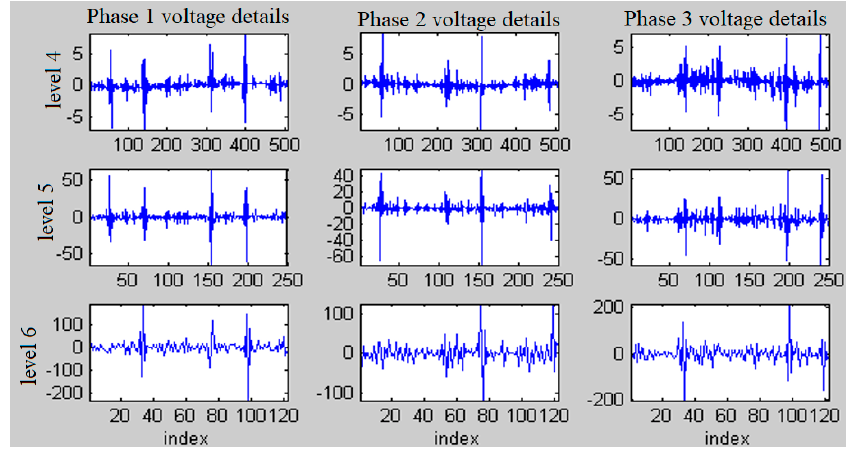
Energies 2022 , 15 , x FOR PEER REVIEW Figure 9. Vectors of details for voltages, levels 4–6, first case study. Figure 9. Vectors of details for voltages, levels 4–6, first case study.